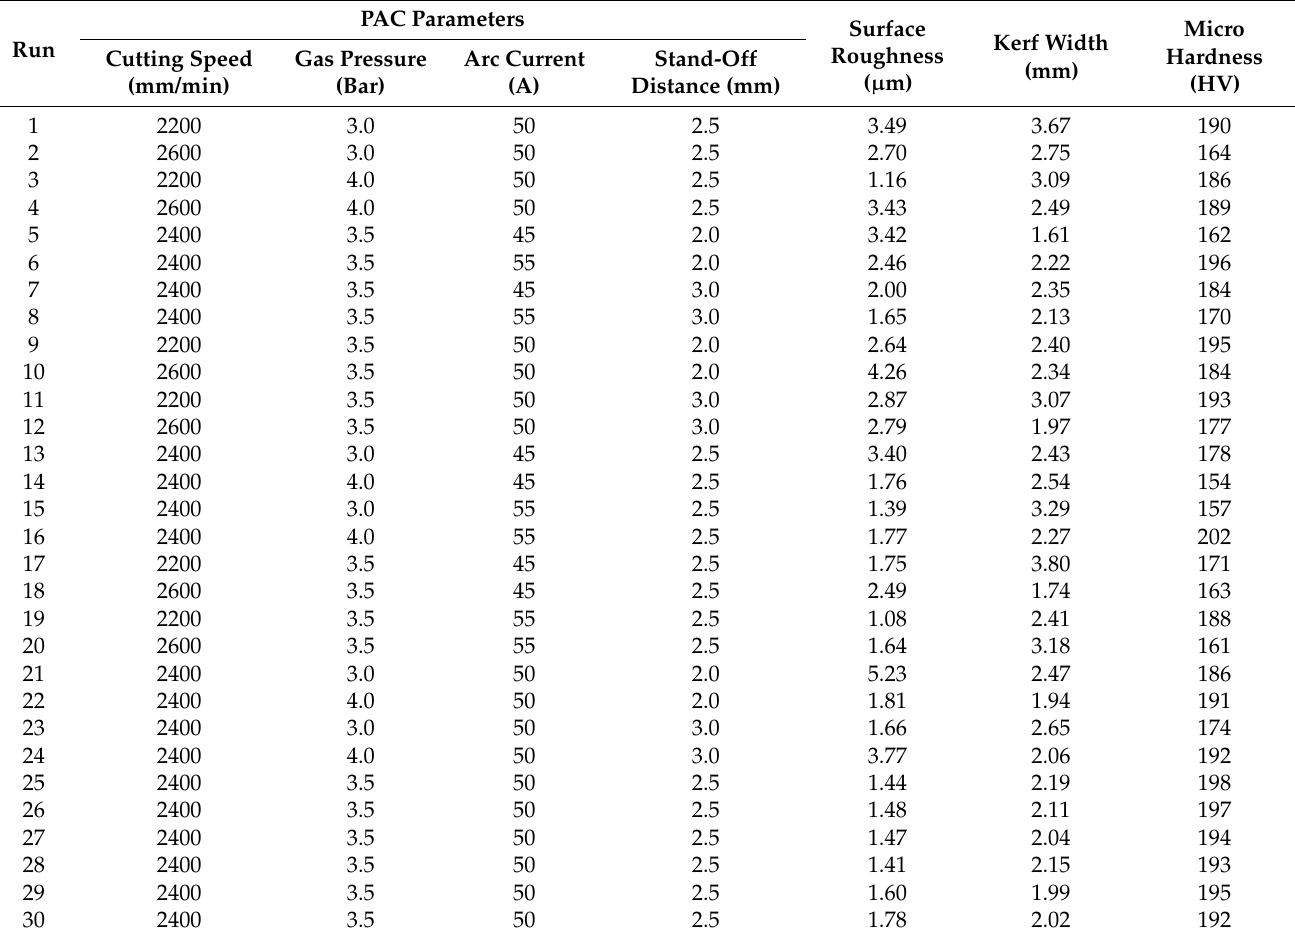
Table 2. Experimentally measured response